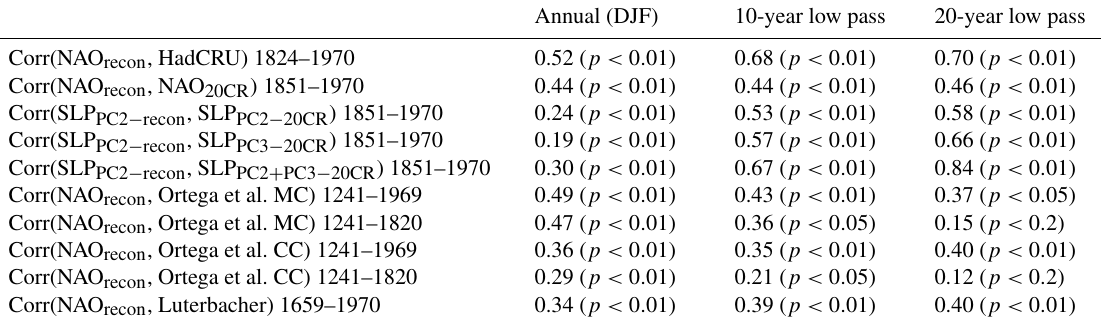
Figure 2. Evaluation of the winter circulation reconstruction. Grid point correlation between reconstructed DJF SLP (a) and T2m (b) , and reanalysis data (Compo et al., 2011) (1851–1970) interpolated to the model grid (lat. × long. ∼ 3 . 75 ◦ × 3 . 75 ◦ ). The white stippling indicates significance p < 0 . 05, and black stippling indicates significance p < 0 . 1. (c) Ensemble mean reconstructed DJF NAO (PC1 of reconstructed DJF SLP Hurrell et al., 2003) with root mean square error (RMSE) compared to observed DJF NAO (Jones et al., 1997), NAOcc and NAOmc by Ortega et al. (2015). (d) Ensemble mean PC2 of reconstructed DJF SLP with RMSE compared to PC2 of reanalysis DJF SLP (Compo et al., 2011). Table 3. Correlations of reconstructed NAO and PC2 of reconstructed SLP, and observed NAO, 20CR PC2 and PC3 of SLP, as well as NAO reconstructions by Ortega et al. (2015) and Luterbacher et al. (2004). All correlations are for detrended data, and p values are calculated with the random-phase test by Ebisuzaki (1997) to take into account